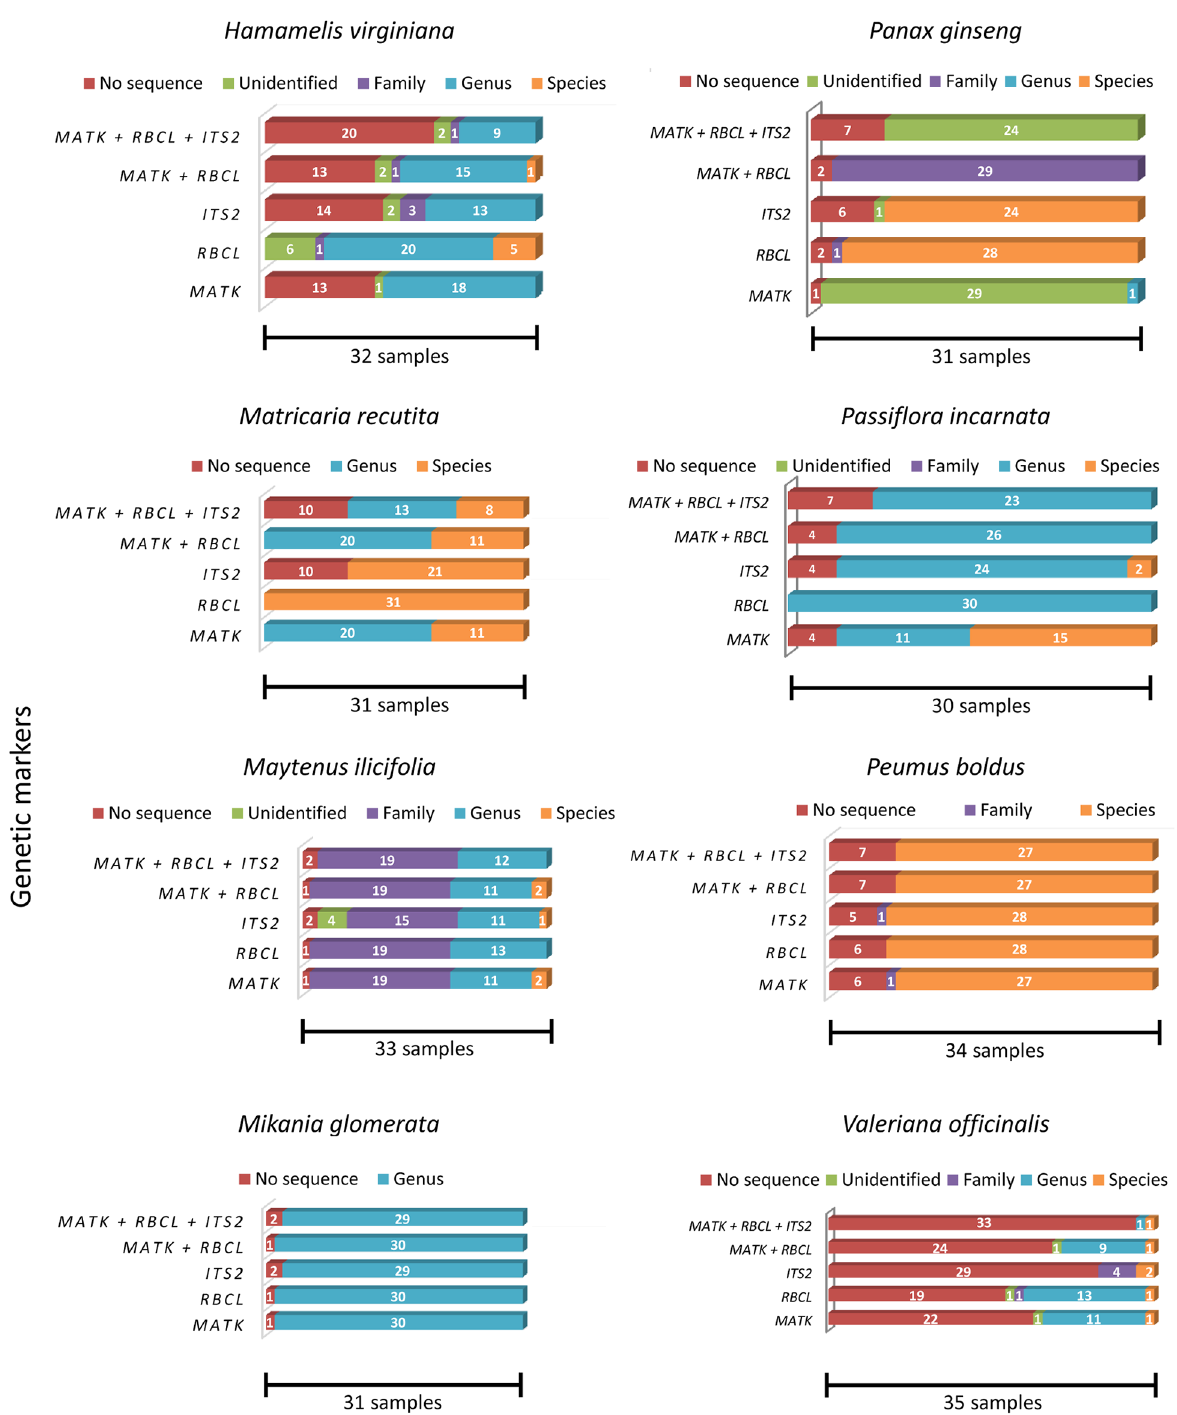
Fig 2. Identification levels for the analyzed samples when using each or a combination of the chosen markers. No sequence: samples for which the DNA barcoding protocol did not work. Unidentified: samples that could not be identified. The sequences from these samples did not show similarity levels above 98% to any of the sequences within the databases. Family: samples that could be identified at the family level. The sequences from these samples showed equal similarity levels to database sequences from multiple species belonging to the same family. Genus: samples that could be identified to the genus level. The sequences from these samples showed equal similarity levels to database sequences from multiple species belonging to the same genus. Species: samples that could be identified to the species level. The sequences from these samples showed similarity levels above 98% to database sequences from a unique